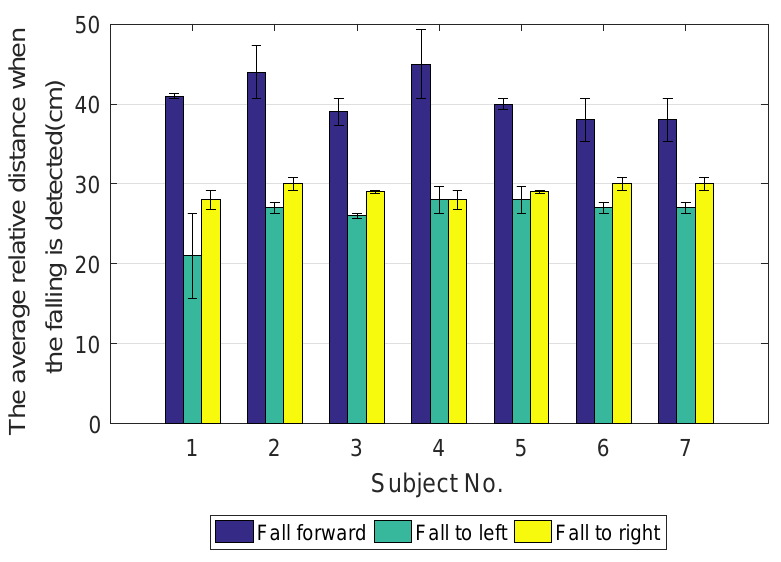
Figure 16. The mean average relative distance when falling is detected (error bar) in seven